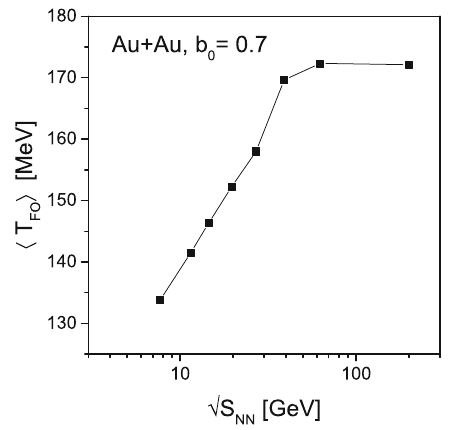
Fig. 3 The global Λ polarization for Au+Au collisions at 7.7–200 GeV with impact parameter ratio b 0 = 0 . 7. The red stars are extracted from our previous work [33], showing the global polarization as a function of collision energy, with the freeze-out time being fixed to t FO = 7 . 24 fm/c. The red squares correspond to the case of varied freeze-out time, t FO = 5.9–7.9 fm/c, with varied collision energy 7.7–200 GeV. The experimental data denoted by up or down triangles are extracted from Ref. [17]